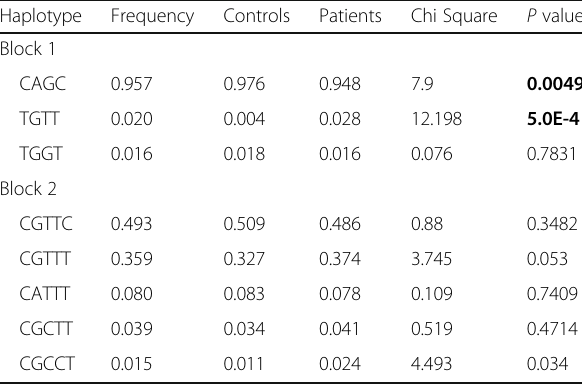
Table 4 Results of haplotype analysis in entire psoriasis